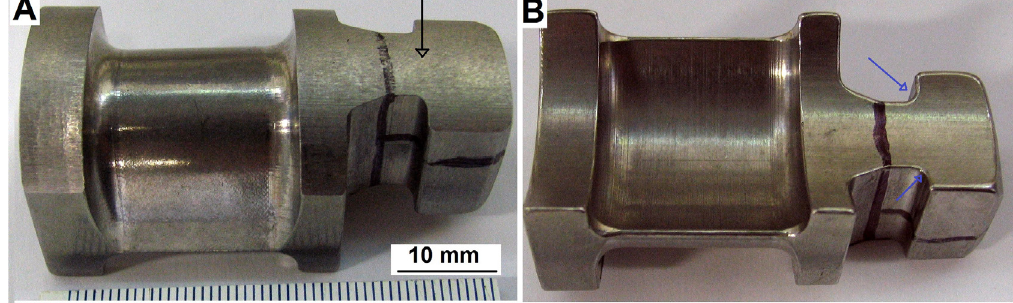
Figure 4. Blade called a virgin blade (VB) without service, seen in the opposite position. (A) The black arrow shows the region in which the metallographic (longitudinal cross-section) analysis was performed. (B) The blue arrow shows a stress concentration region at the blade’s base, inherent in the